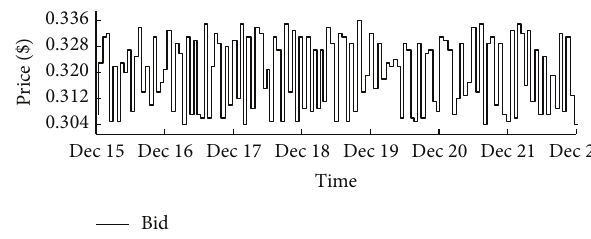
Figure 4: Price history of EC2’s spot instances for c1-xlarge.